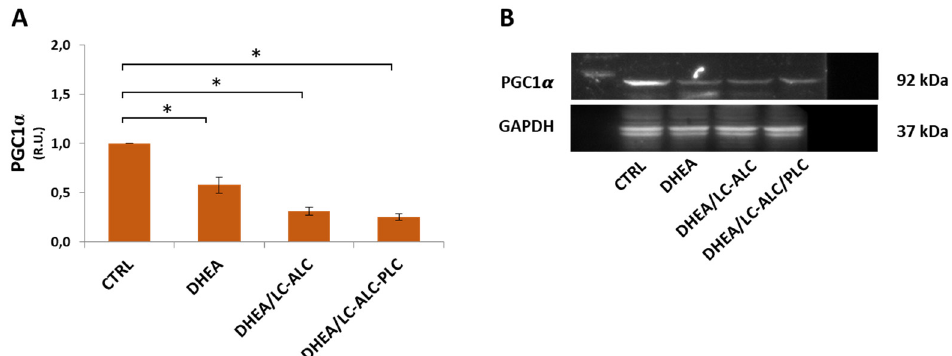
Figure 10. Western blot analysis of PGC1 α ( A ) and representative images ( B ). Three mice per exper ‐ imental group were employed. Experiments were conducted in triplicate. Data obtained from n = 9 observations are presented as means ± SEM of densitometric analysis of immunoreactive bands nor ‐ malized to internal reference protein (glyceraldehyde ‐ 3 ‐ phosphate dehydrogenase, GAPDH). * p < 0.01 vs. CTRL, t ‐ test.